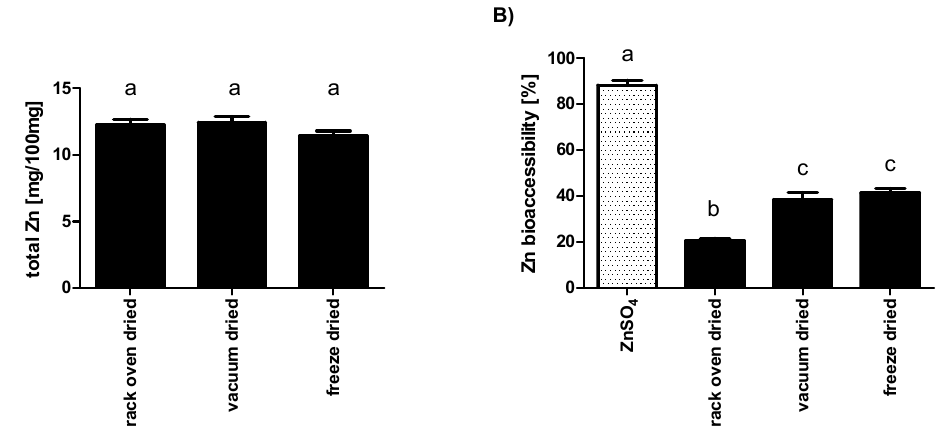
Figure 2. Total amount and bioaccessibility of zinc from dried Tenebrio molitor larvae. Mealworm larvae were analyzed for zinc content before or after incubation with gastrointestinal digestive secretions using flame atomic absorption spectrometry. The total zinc content ( A ) as well as Zn bioaccessibility ( B ) were calculated. Data are shown as means ± SEM of three replicates. Significantly different means do not share the same letters (analyzed by one-way ANOVA with Bonferroni’s multiple comparison test). From a nutritive perspective the bioaccessibility, i.e., the amount of zinc enzymatically released and potentially available for absorption, is far more relevant than the absolute mineral content